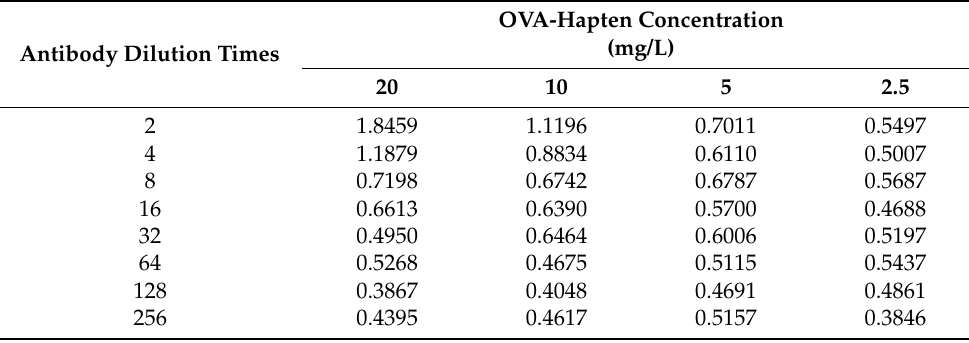
Table 2. The optimal concentrations of antigen and antibody for